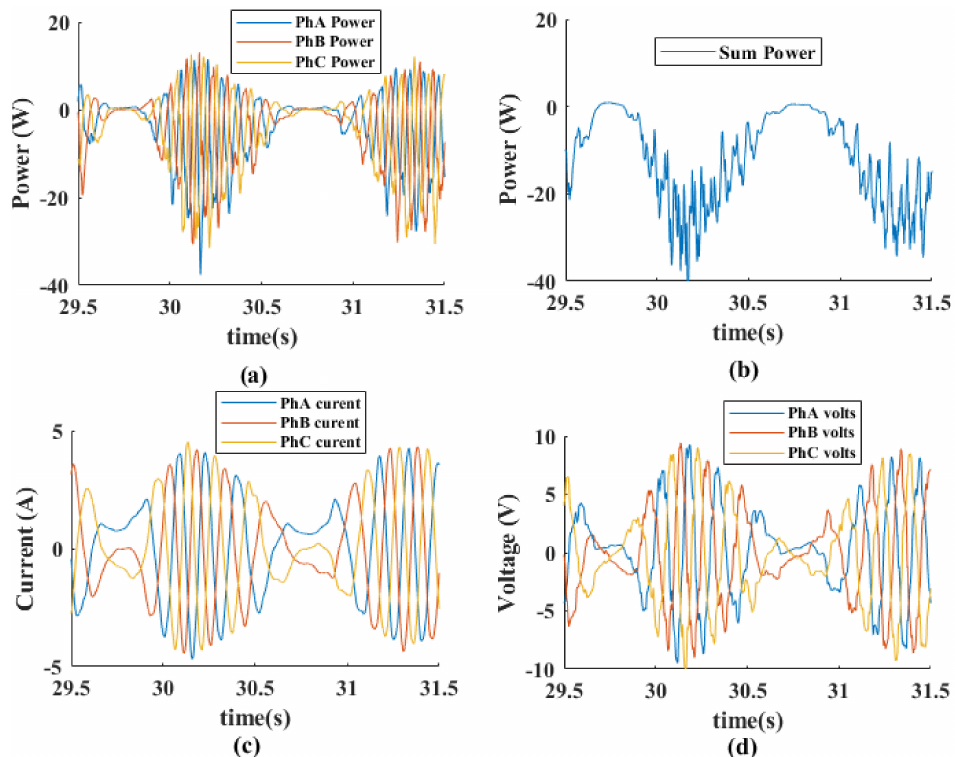
Figure 16. Typical generator output waveforms of ( a ) power per phase; ( b ) total power (average − 10.9 W); ( c ) phase currents and ( d ) phase voltages. H = 0.2 m, f = 0.5 Hz, B